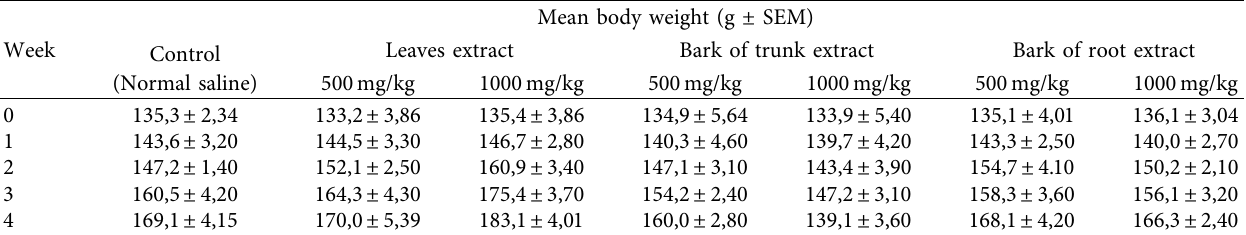
Table 2: Mean body weight of rats after 28-day treatment with hydroethanolic leaf, bark of trunk, and of bark root of P. santalinoides .